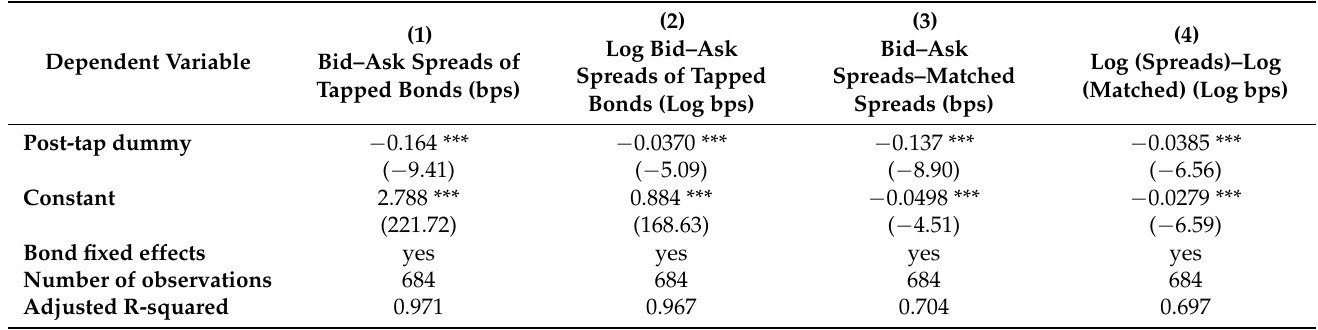
Table 1. Impact of taps on an EU bond’s bid–ask spread. Panel regression results for N = 17